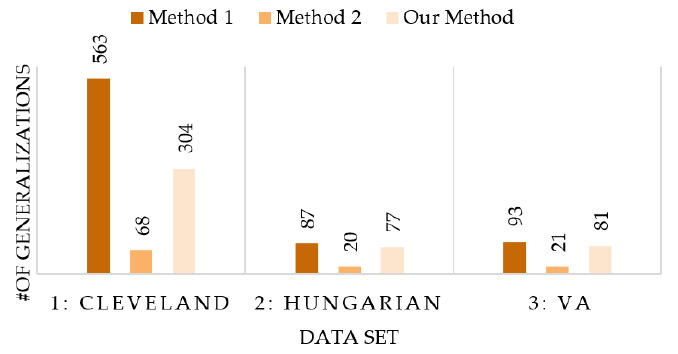
Figure 8. Total Number of Generalizations.